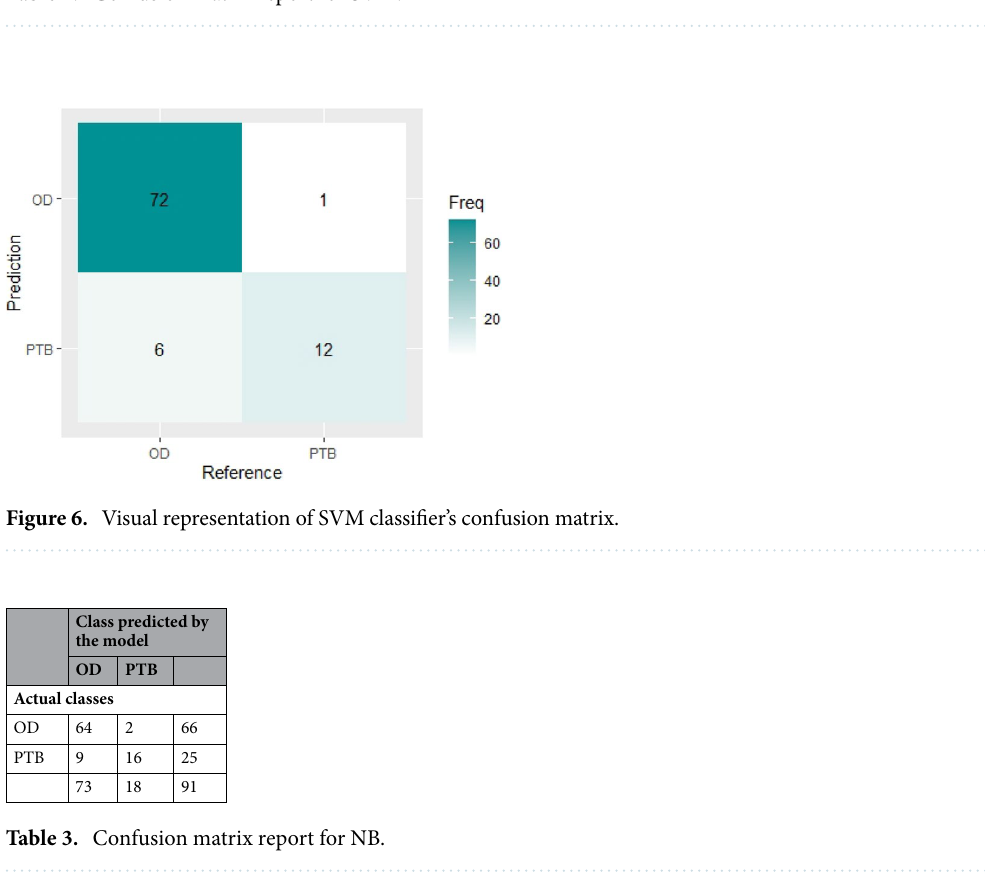
Table 2. Confusion matrix report for SVM.